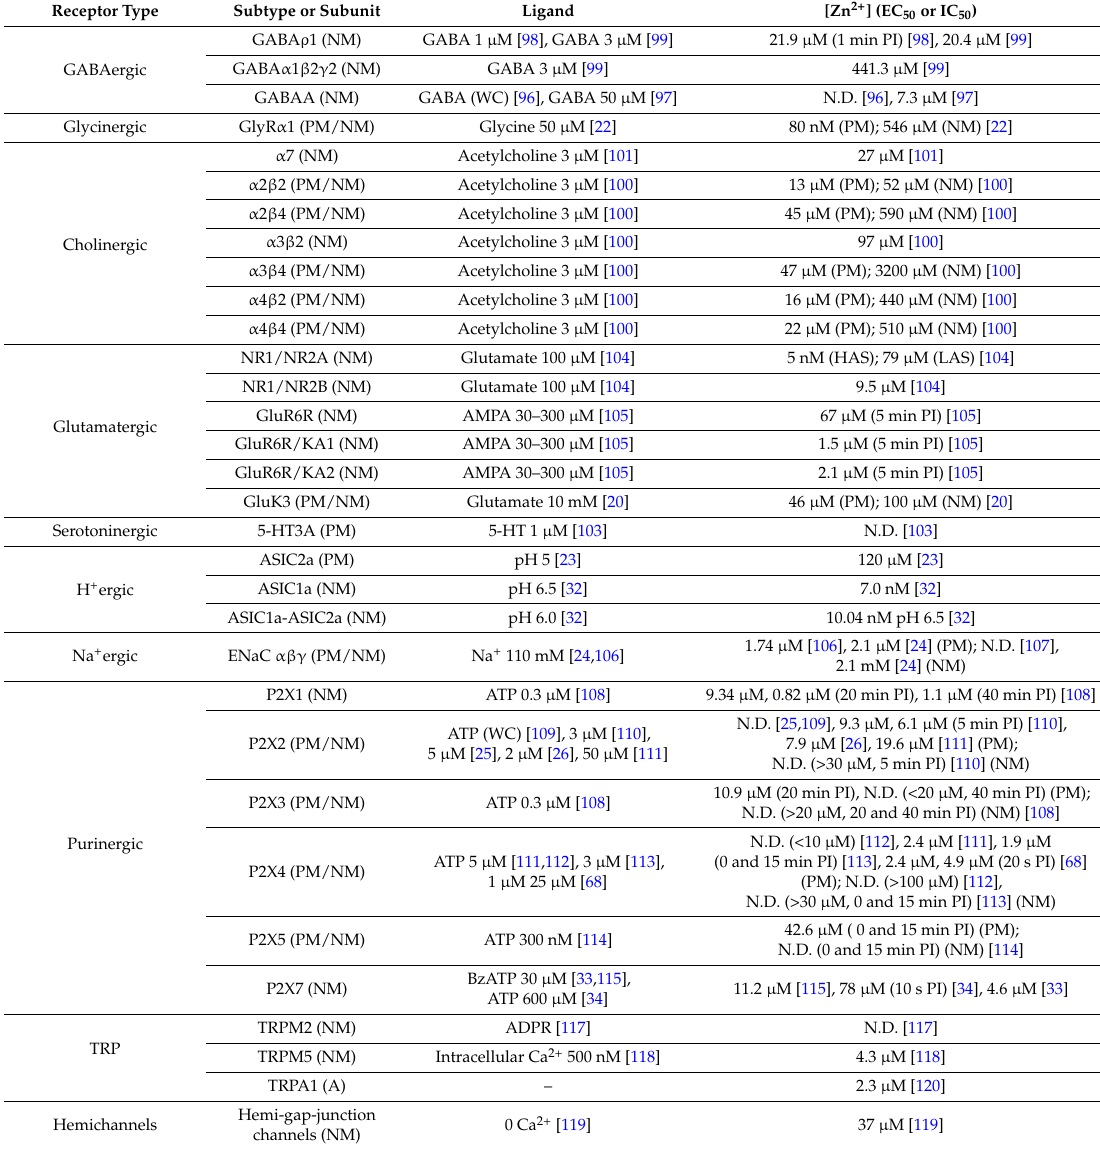
Table 4. Ligand-gated ionotropic receptors modulated by